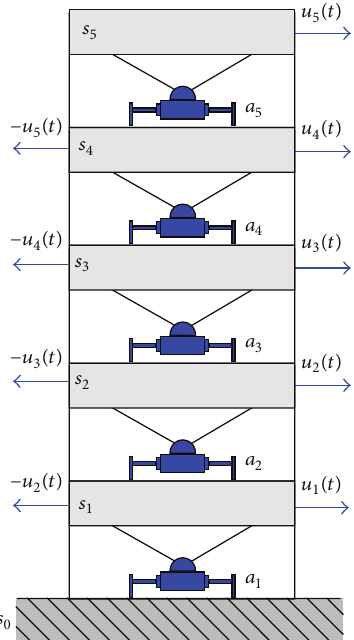
Figure 1: Five-story building actuation